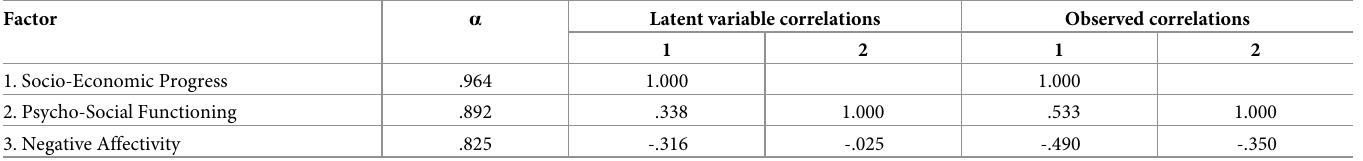
Table 5. Factor correlations and alphas.